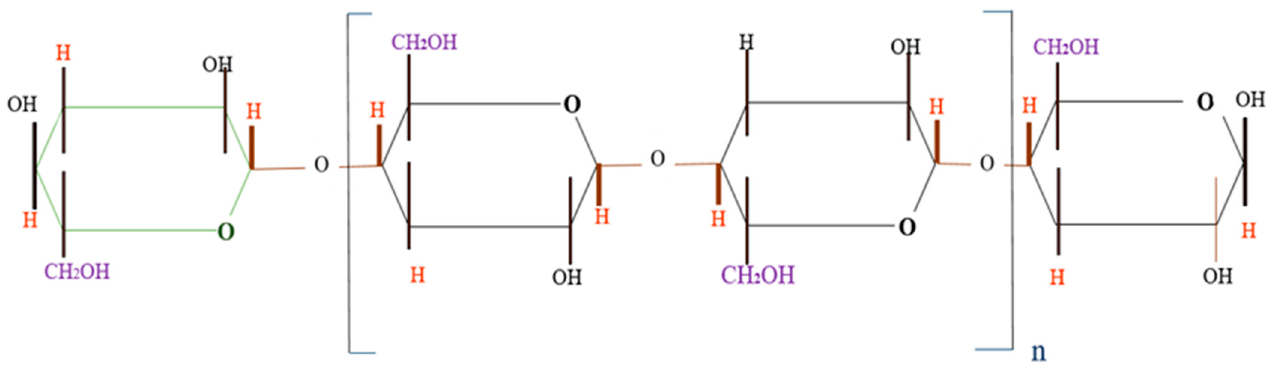
Figure 1. The chemical structure of cellulose.